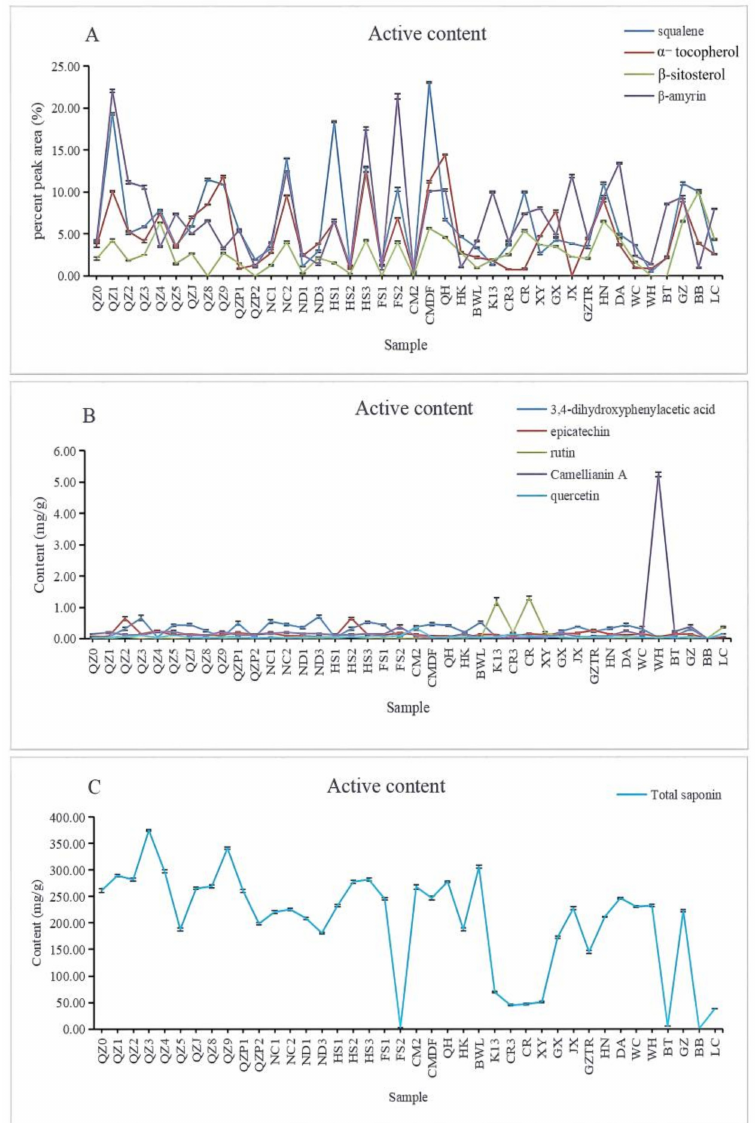
Figure 1. The variation tendency of active content in Camellia spp. from 40 samples, respectively ( p ≤ 0.01). ( A ): The content of minor compounds from the oil by GC–MS; ( B,C ): The content of polar compounds from the extraction meal determined by